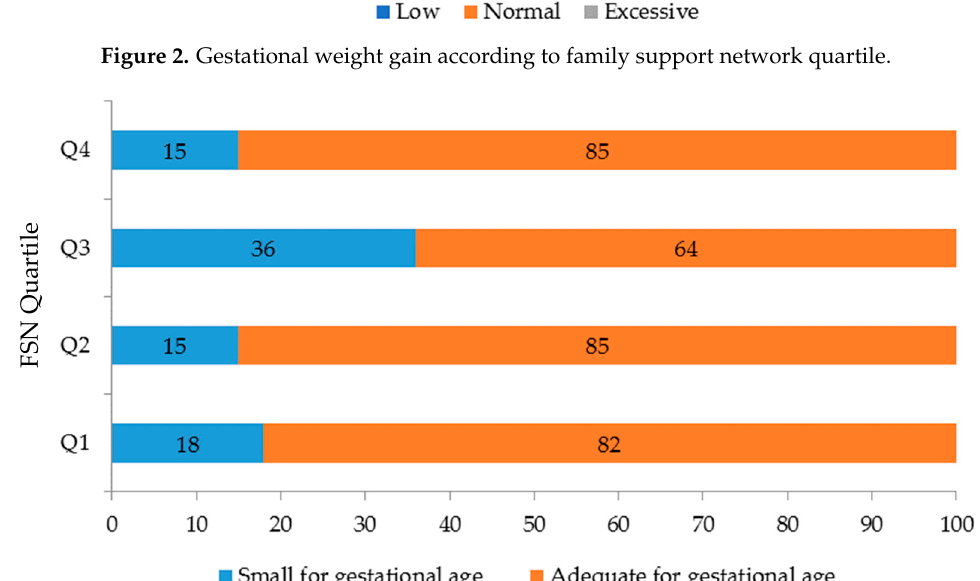
Figure 2. Gestational weight gain according to family support network quartile.